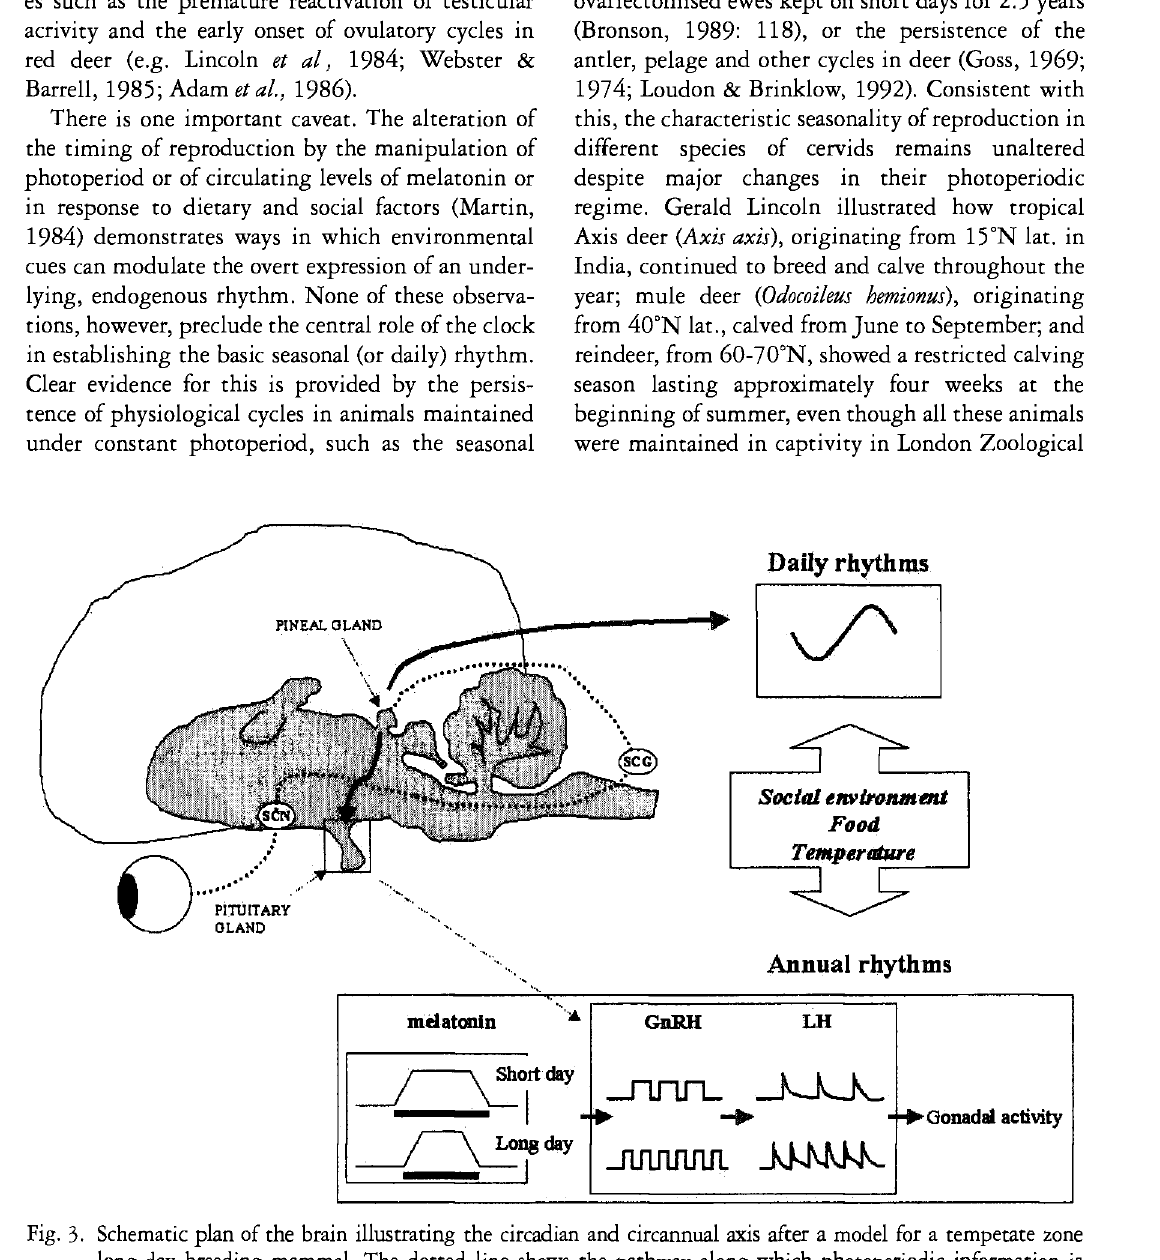
Fig. 3. Schematic plan of the brain illustrating the circadian and circannual axis after a model for a tempetate zone long-day breeding mammal. The dotted line shows the pathway along which photoperiodic information is transmitted to the pineal gland. Light acts both to entrain the phase of the daily endogenous rhythm of the SCN and to suppress melatonin secretion in the pineal gland. The two bold arrows show the pathways along which photoperiodic information, translated into a melatonin rhythm, is believed to influence daily and annual rhythms of physiological function and behaviour. The duration of melatonin secretion acts, for example, via the pituitary gland to modulate the pulsatile sectetion of GnRH, thus regulating the activity of the reproductive axis. Daily and annual rhythms are also modulated by non-photic environmental input. (SCN = suprachiasmat- ic nucleus, SCG = supracervical ganglion, LH = Luteinising hormone, GnRH = Gonadotropin releasing hor